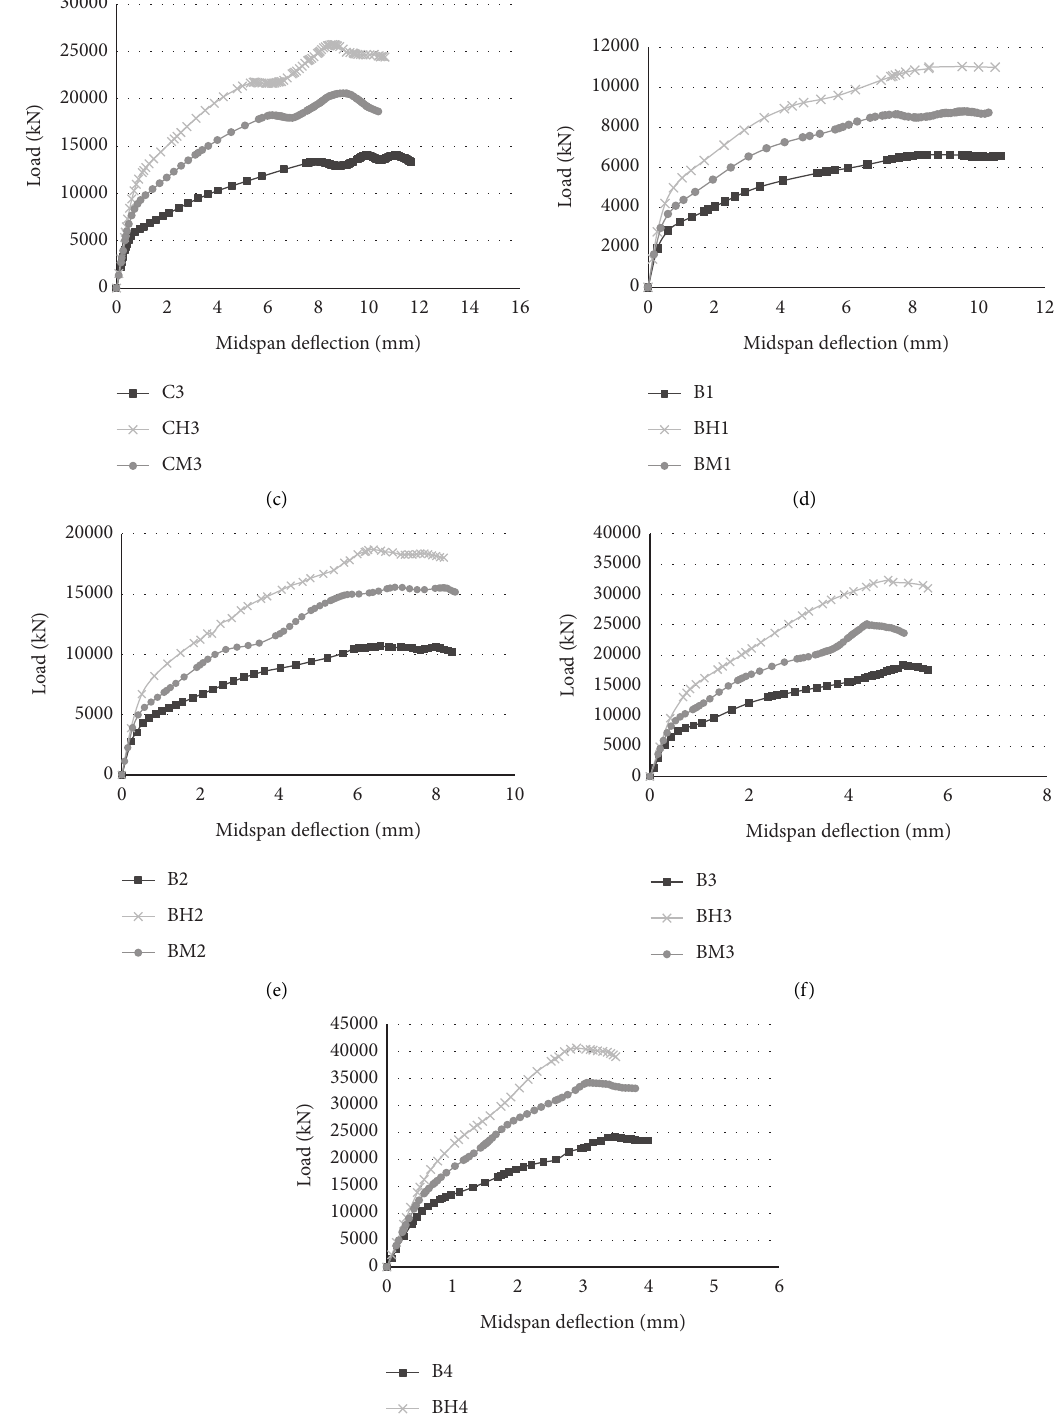
Figure 9: Load-deflection diagrams of continuous deep beams with different a / h ratios and f CH2. (c) C3, CM3, and CH3. (d) B1, BM1, and BH1. (e) B2, BM2, and BH2. (f) B3, BM3, and BH3. (g) B4, BM4, and